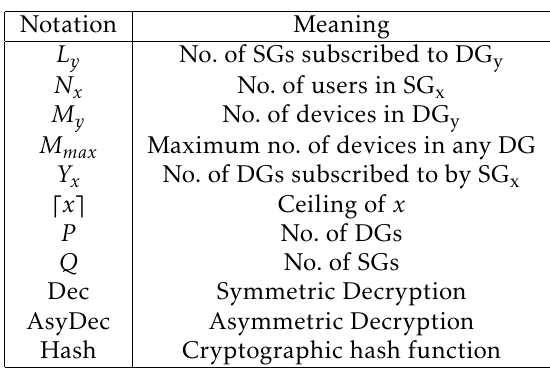
Table 1. Notation used in Sections 6 and